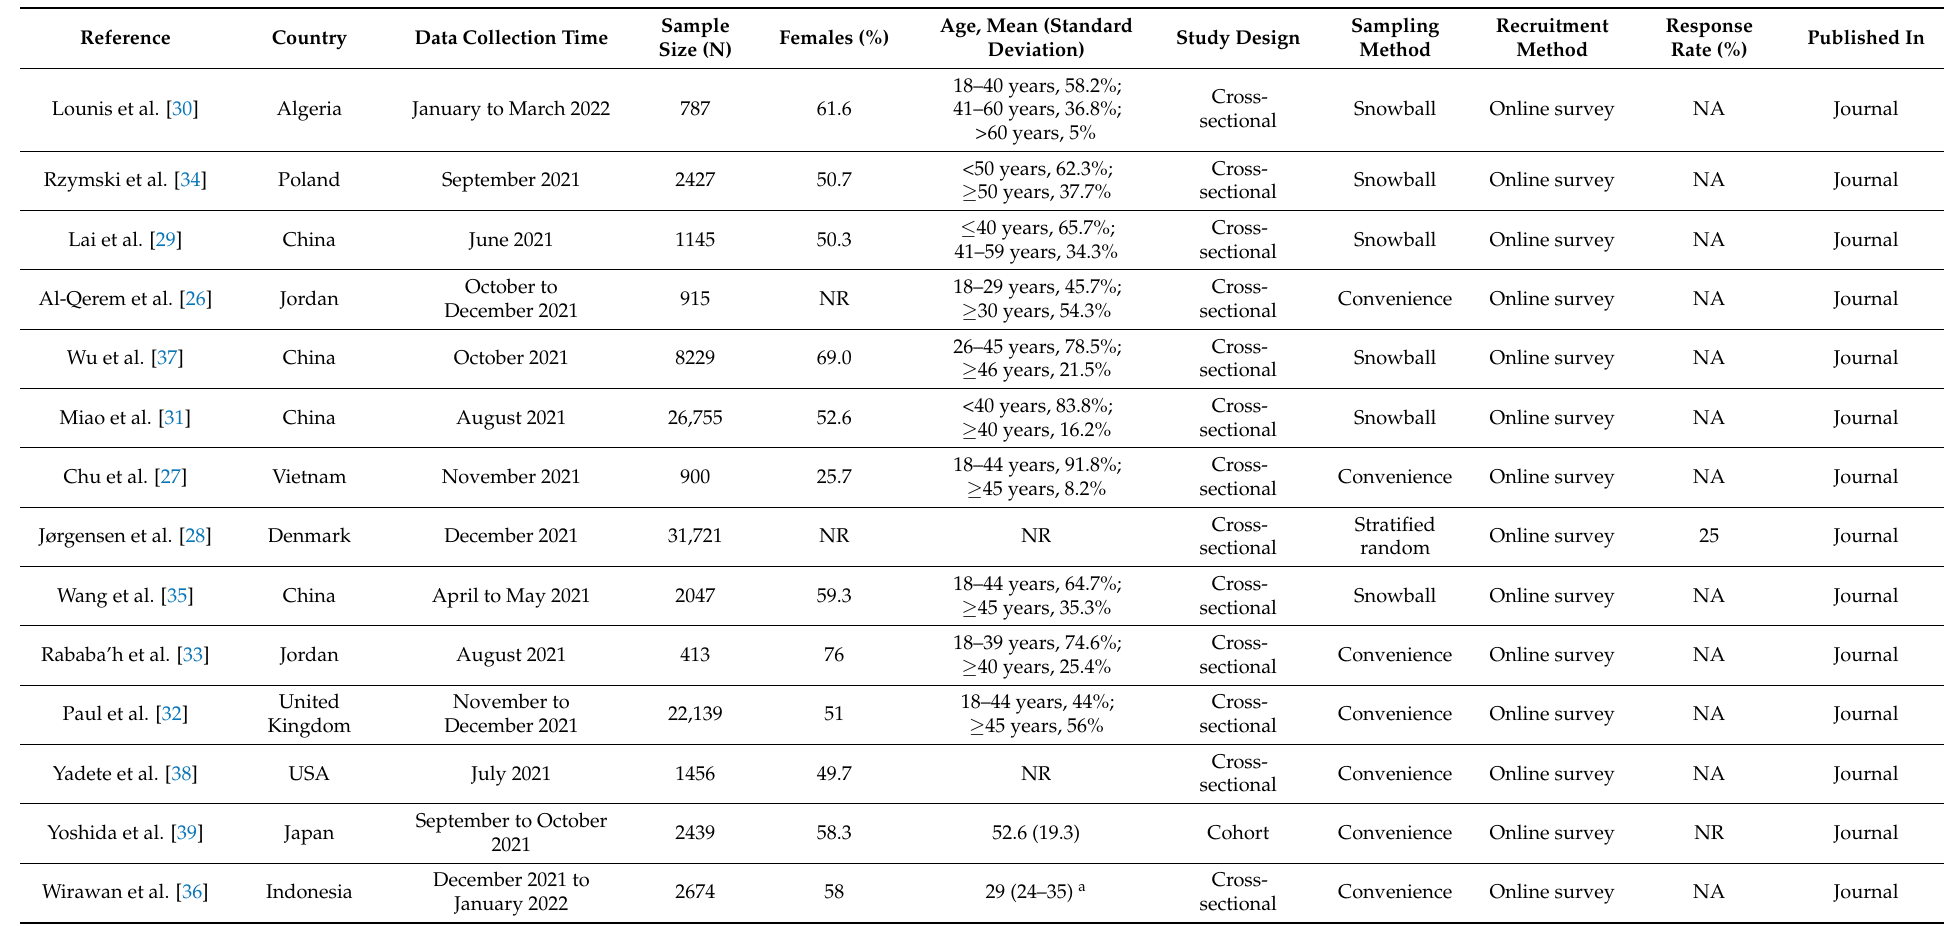
Table 1. Overview of the studies included in this systematic